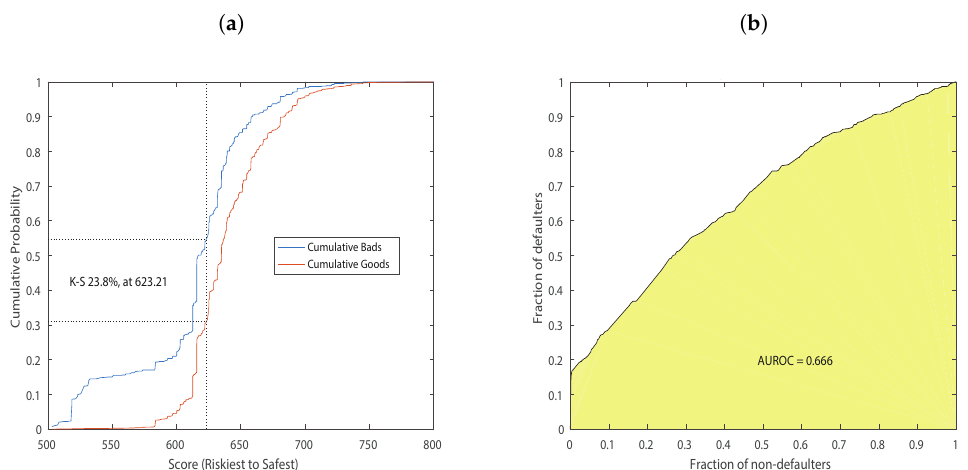
Figure 2. Panel ( a ) illustrates the Kolmogorov-Smirnov curve and the associated statistics for the first pool cut-off date. We show that the KS statistic associated to a score of 623.21 is 23.8%. Panel ( b ) reports the ROC curve and the AUROC value for the first report date. Table 6 reports AUROC, KS statistic and KS score for the entire